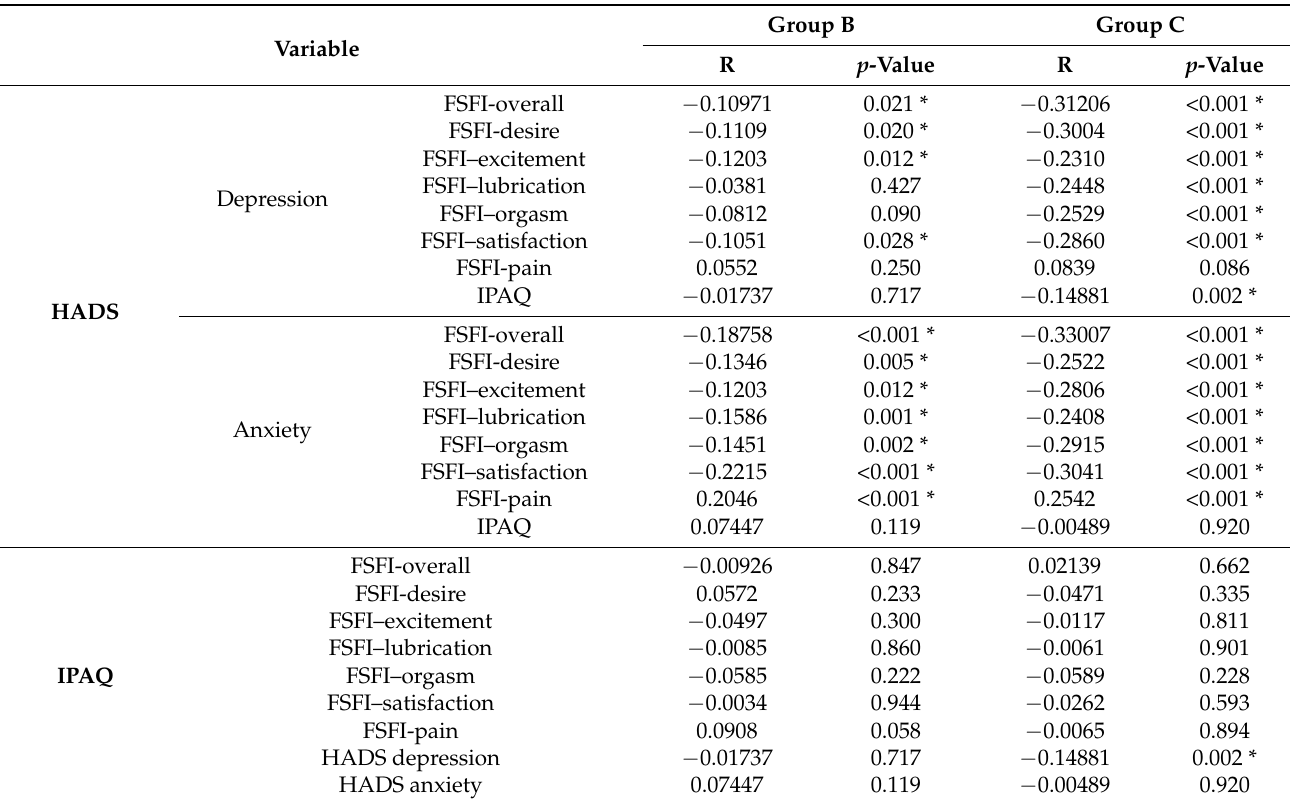
Table 4. Correlations between the results of the